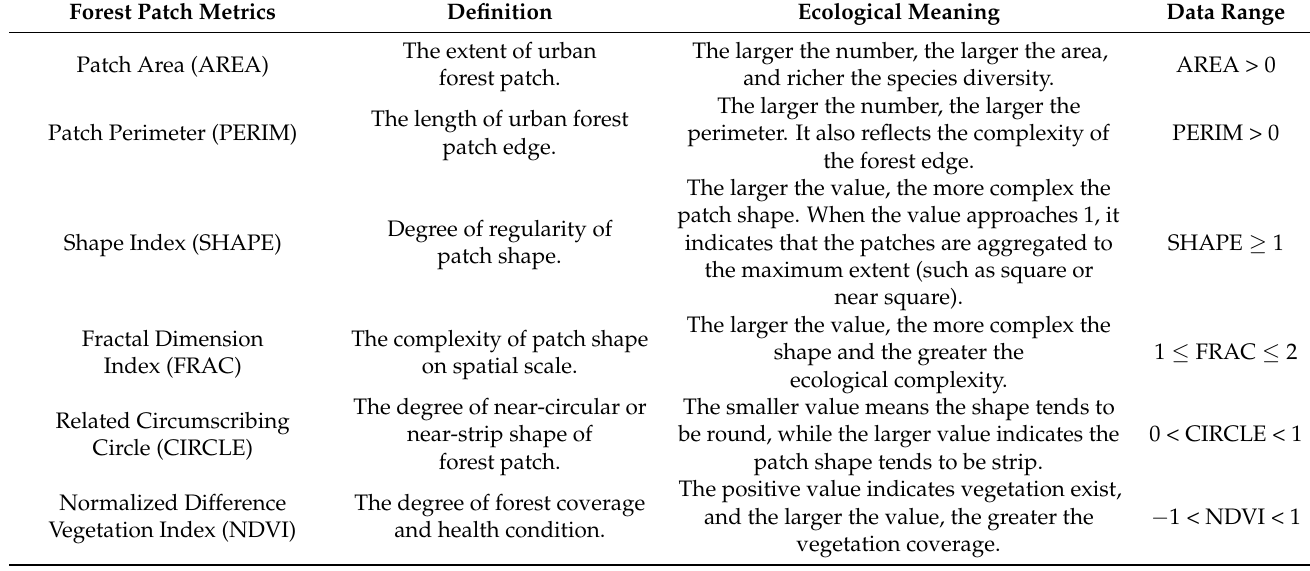
Table 1. Name, meaning, and range of forest patch characteristic